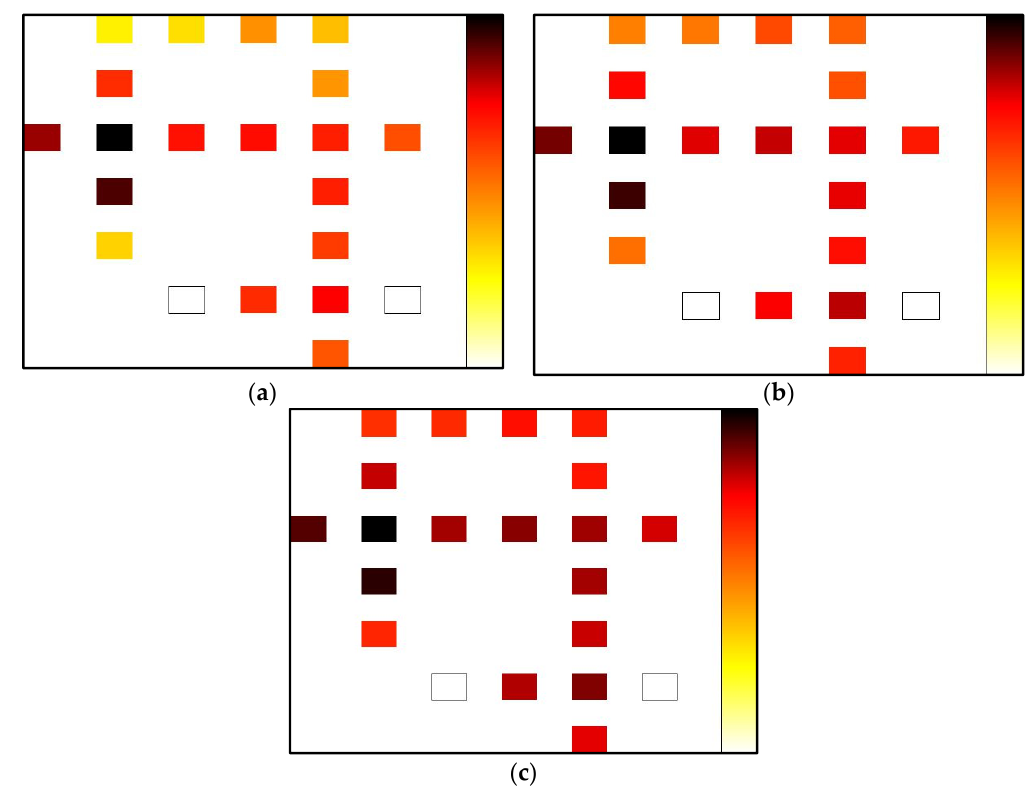
Figure 22. Map of energy dissipation for proposed DFF at T = 2K and ( a ) 0.5 Ek, ( b ) 1.0 Ek, ( c ) 1.5 Ek γ -factor. Table 3. Values of energy dissipation for proposed DFF design at different γ -factor levels. Table 4. Values of energy dissipation for proposed 2-bit PIPO design at different γ -factor levels. Type of Energy